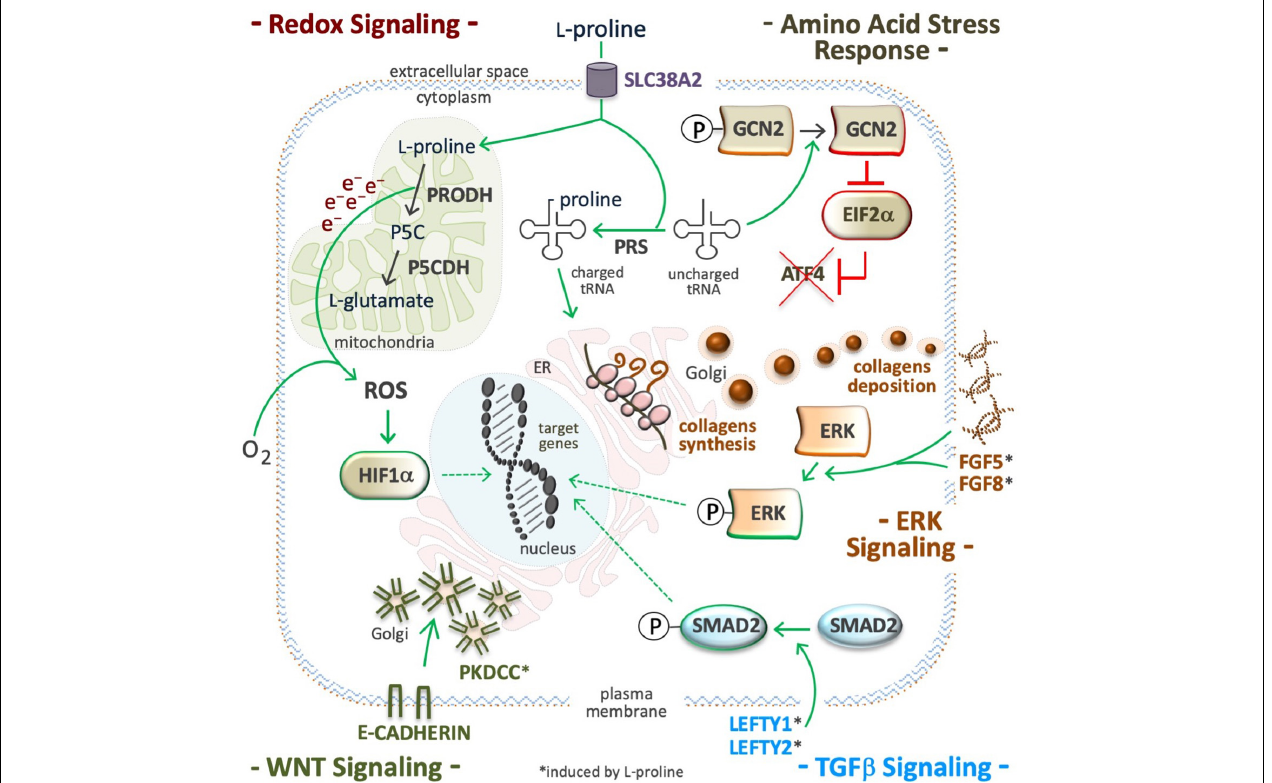
FIGURE 6 | Proline modulates signaling pathways. Supplemental proline, after being transported into the cell cytoplasm can be used and/or for mitochondrial oxidation (catabolism) and/or for the loading of uncharged tRNA (anabolism). ROS are byproducts of proline oxidation ( top left ) and their accumulation can stabilize the hypoxia inducible factors (HIF), and modulate redox signaling ( middle left ) . Proline-tRNA loading induces dephosphorylation (inactivation) of the general control non-repressible 2 (GCN2) kinase, also known as eukaryotic translation initiation factor 2 alpha kinase 4 (EIF2AK4). The inactive form of GCN2 is unable to phosphorylate eukaryotic translation initiation Factor 2A (EIF2A), and to promote translation of activating transcription factor 4 (ATF4), so inactivating the amino acid stress response (AAR). Proline-tRNA loading also improves collagens expression, which are modulators of the integrin linked kinase/extracellular signal-regulated Kinase (ILK/ERK) super-pathway ( middle right ) . Proline abundance induces left-right determination factors (LEFTY1, LEFTY2), the phosphorylation of mothers against decapentaplegic homolog 2 (SMAD2), and thus, the activation of the transforming growth factor beta signaling pathway ( bottom right ) . Proline abundance also induces the expression of the protein kinase domain containing, cytoplasmic (PKDCC), and the delocalization the E-cadherin from plasma membrane to trans Golgi ( bottom left )